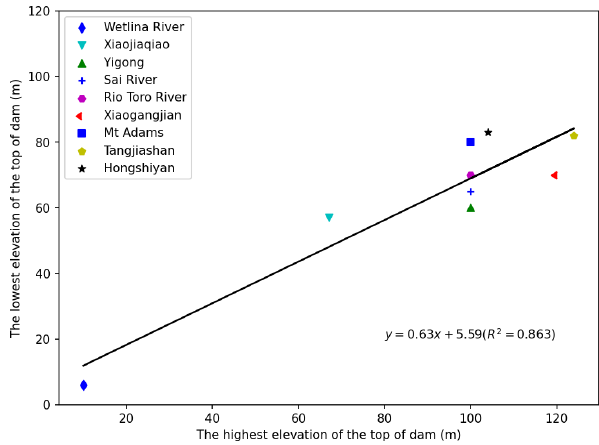
Figure 4. The relationship between the highest elevation of the dam crest and the lowest elevation of the dam crest. These data can be found in the papers of Cui, Costa, Mora and so on (Costa and Schus- ter, 1991; Mora Castro, 1993; Briaud, 2008; Cui et al., 2009; Peng and Zhang, 2012; Chen et al.,